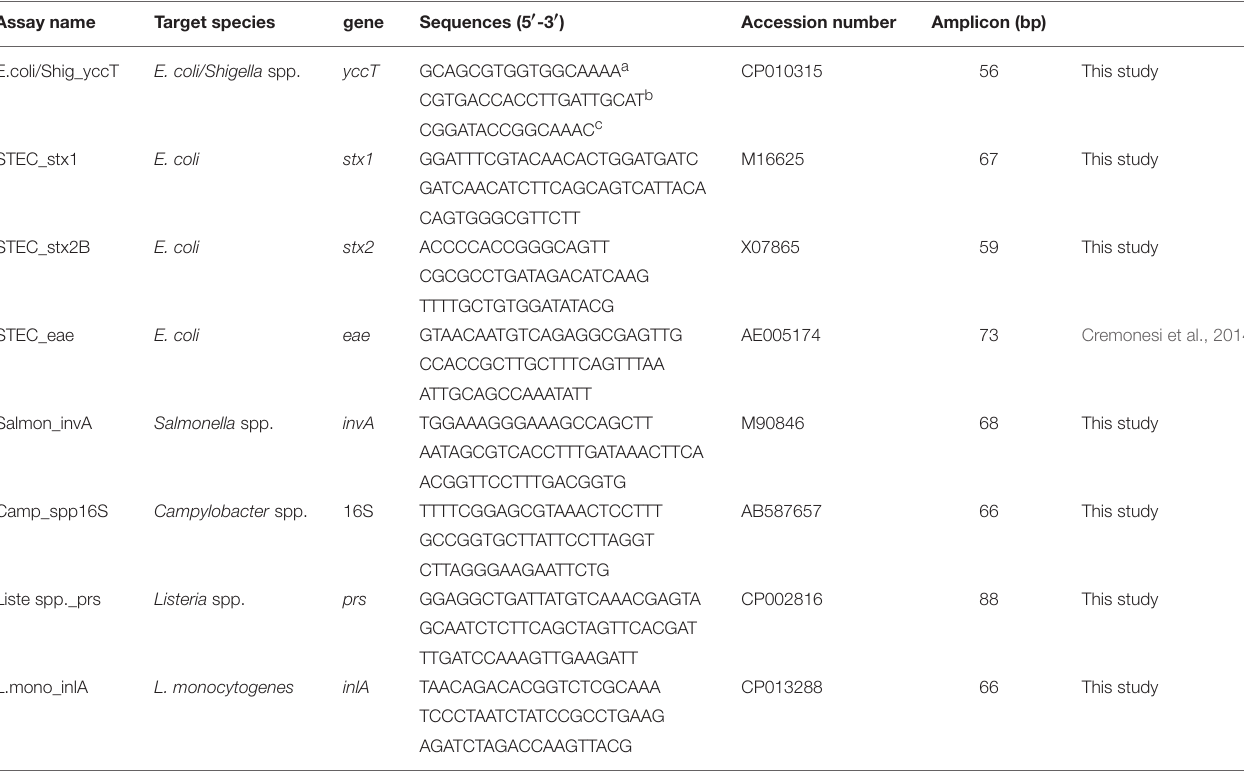
TABLE 2 | TaqMan TM assays used for qPCR and